Question: Write the caption for this figure.
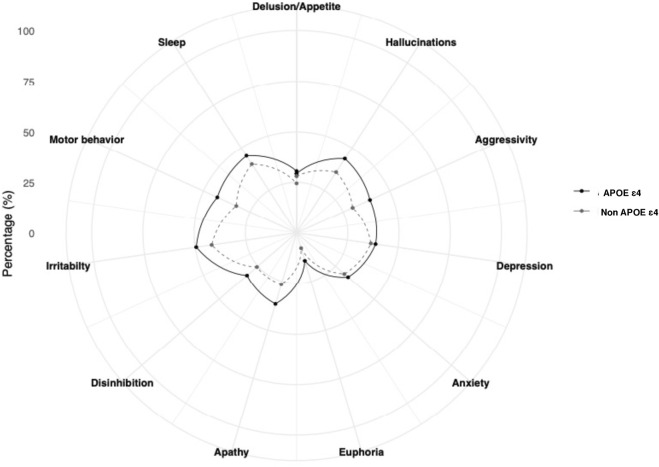
Answer: Comparison of altered neuropsychiatric items in AD patients according to APOE ε4 carriage.